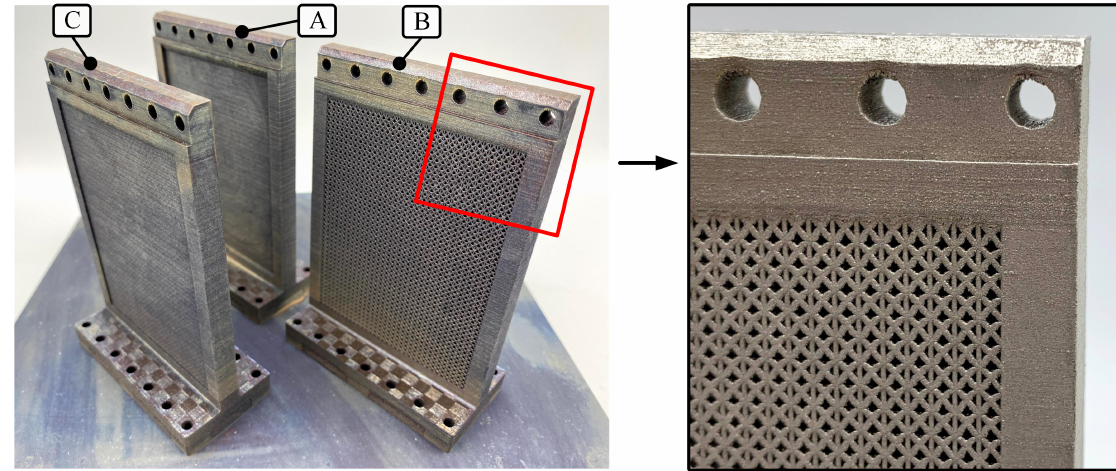
Figure 9. SLM 3D printed supports: reference ( A ), lattice ( B ), and lattice + powder ( C